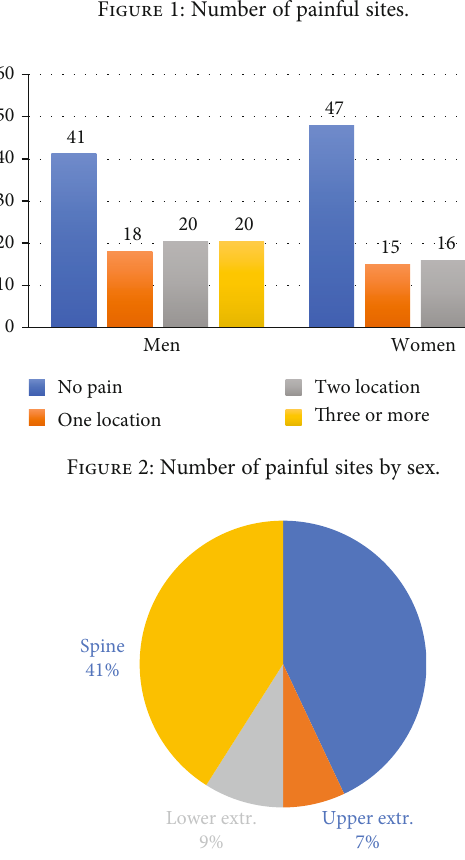
Figure 3: Location of painful sites.